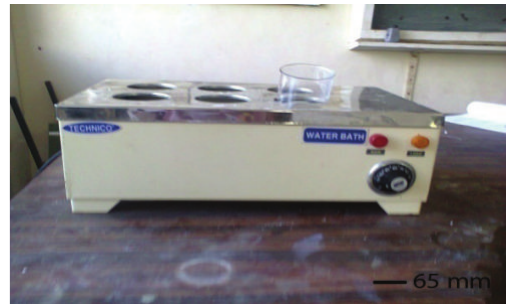
Figure 2: Experimental setup used for EN-coatings.